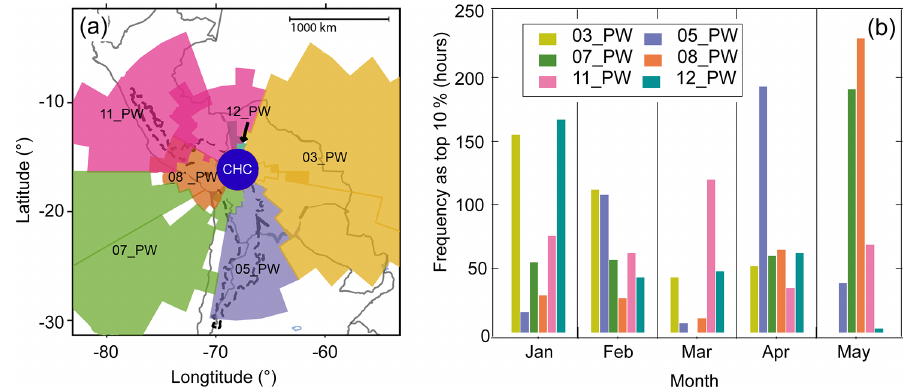
Figure 2. Influence of the six air pathways on CHC from January to May 2018. (a) Horizontal profile of the air mass pathways, adapted from Aliaga et al. (2021). (b) Frequency of the representative periods for each pathway (the highest 10% of their corresponding SRR[%] pathway ) in different months. Table 1. Overview of the six air mass pathways extracted from Aliaga et al. (2021).